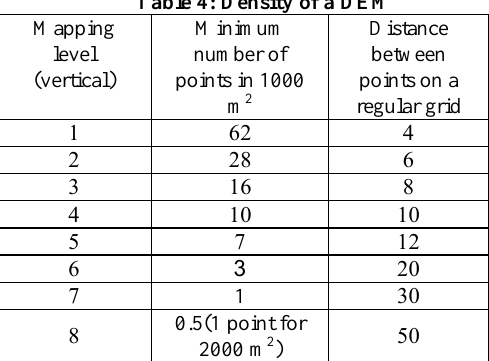
Table 4: Density of a